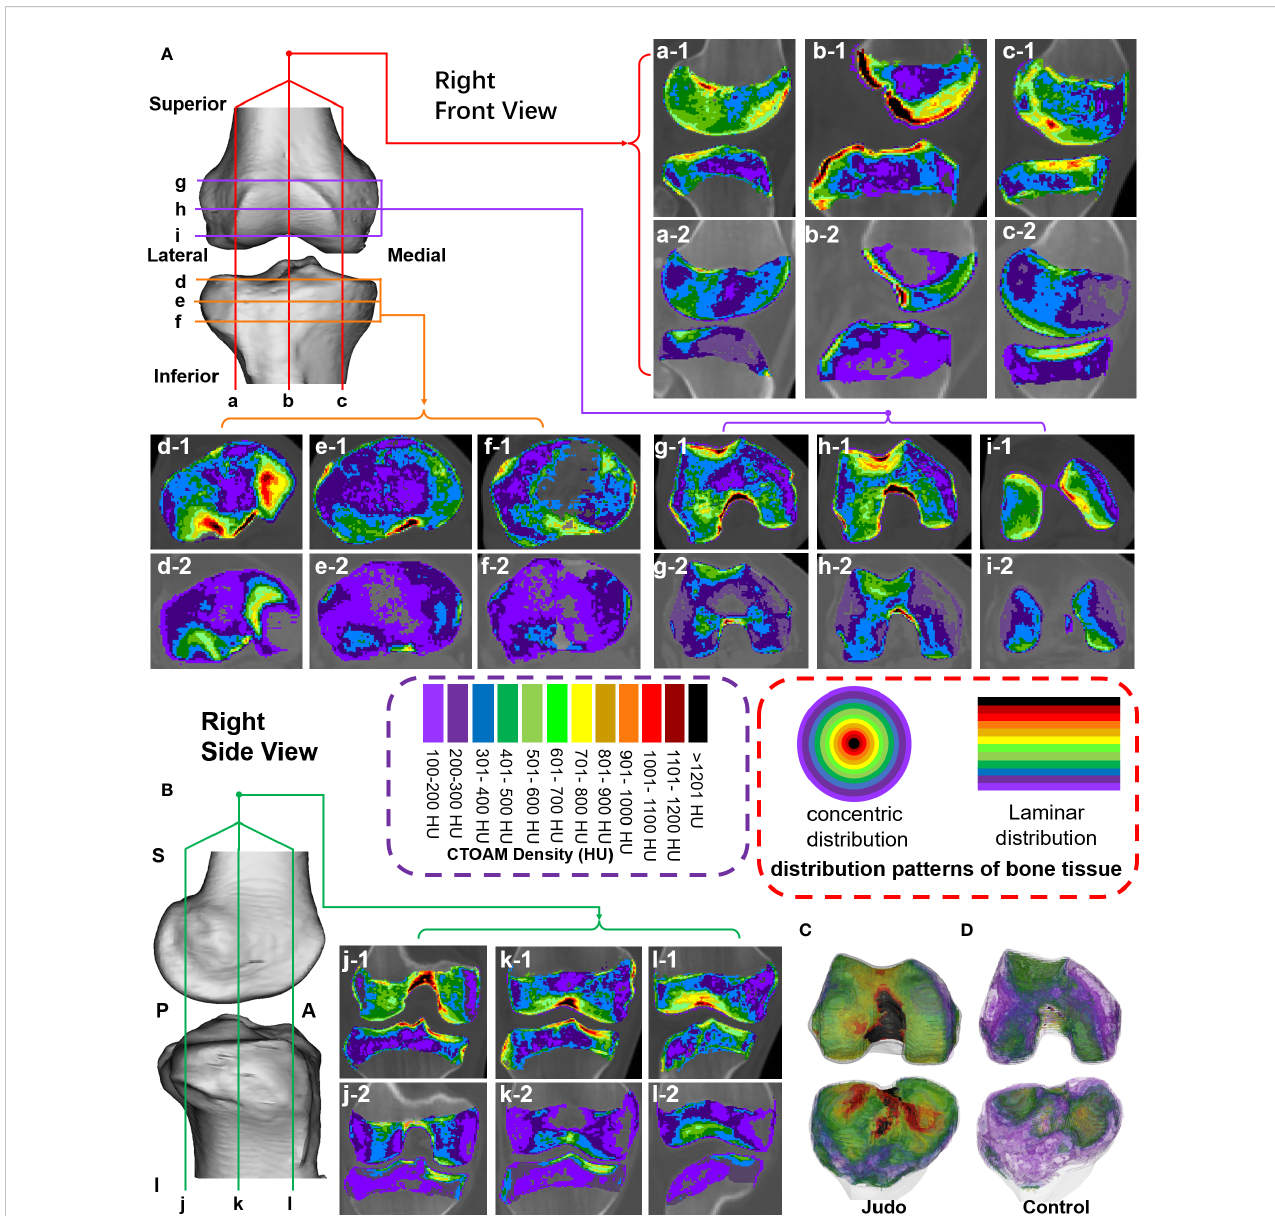
FIGURE 2 Tomographic images of the distribution of bone tissue with different bone density in the subchondral bone of the knee joint surface in two groups of subjects. (A) Sagittal and axial tomographic sections of the knee joint; (B) Coronal sections of the knee joint; (C, D) Superimposed images of different bone density in the knee joint of judo athletes and control subjects. (1-a – c-1) are sagittal images of judo athletes; (d-1 – f-1) are axial images of tibial plateau of judo athletes; (g-1 – i-1) are axial images of distal femur of judo athletes; (j-1 – l-1) are coronal images of judo athletes. (a-2 – c-2) are sagittal images of control subjects; (d-2 – f-2) are axial images of tibial plateau of control subjects; (g-2 – i-2) are axial images of distal femur of control subjects; (j-2 – l-2) are coronal images of control